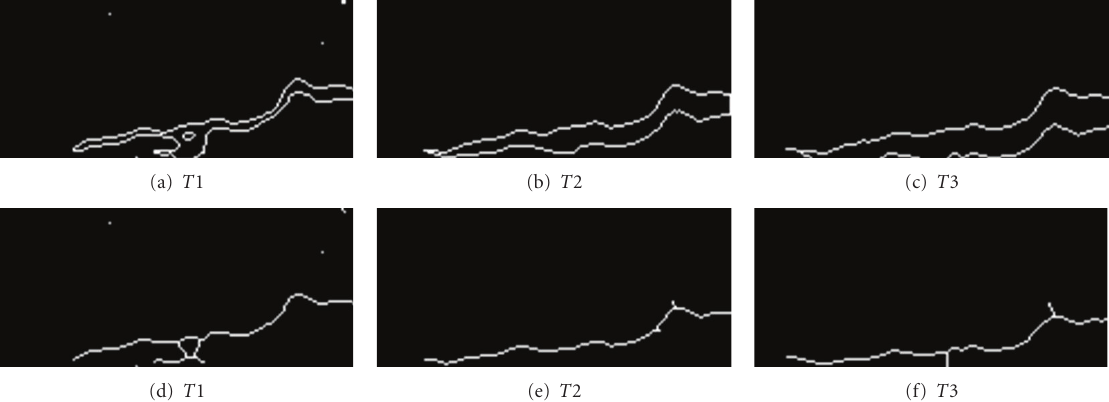
Figure 14: (a)–(c) Boundaries of detected cracks at di ff erent times; (d)–(f) extracted centerlines of detected cracks by morphological skeltonization.